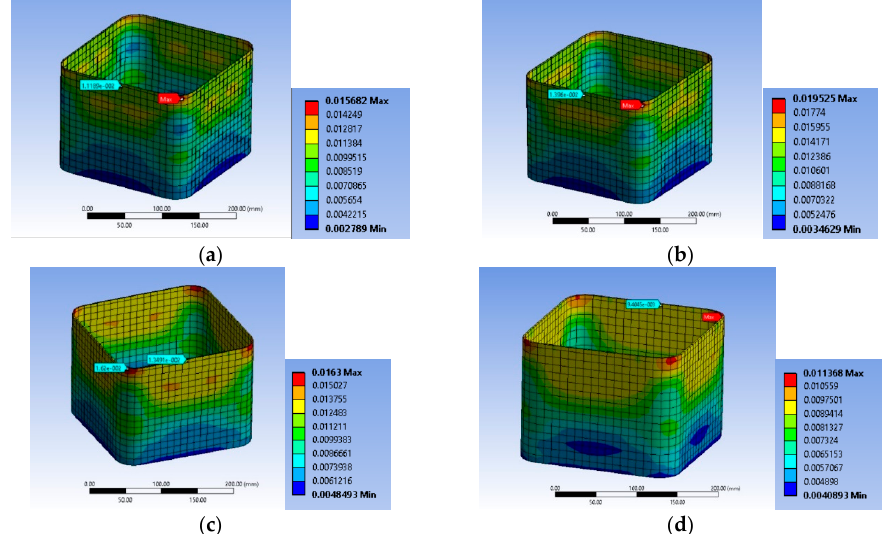
Figure 9. Variation of the CFRP strain and characteristic values of specimen BS2C1C ( a ) one step after